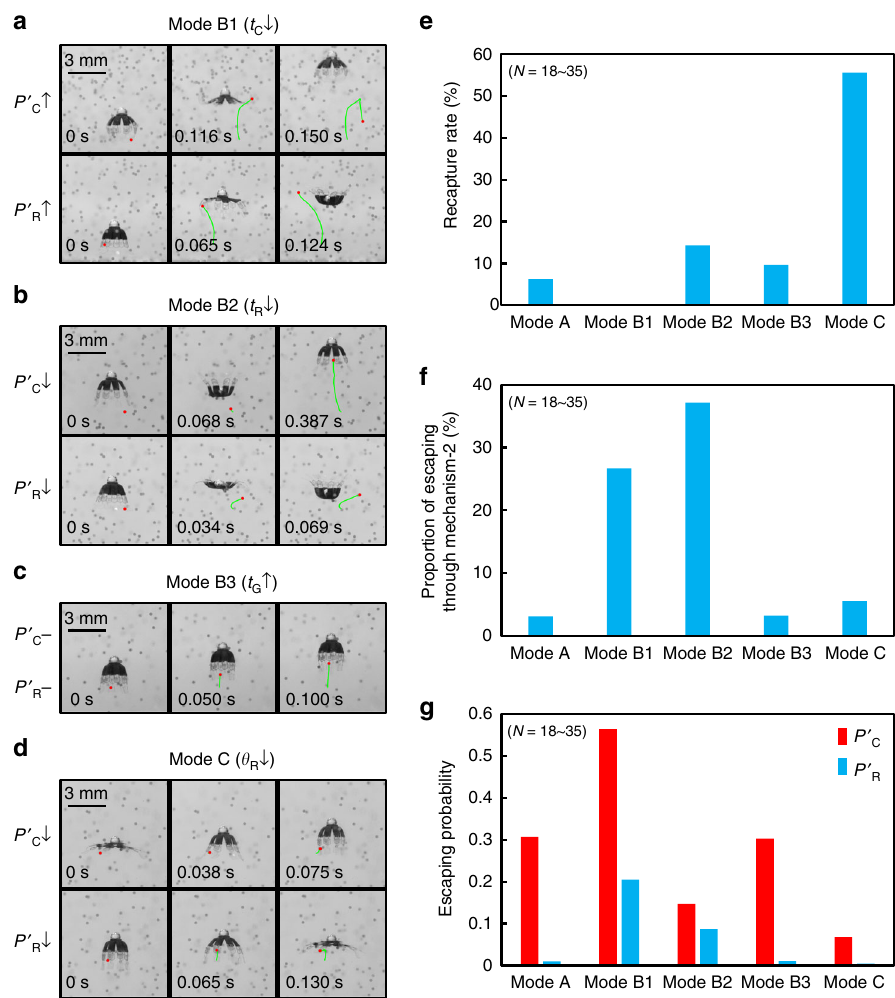
Fig. 5 The in fl uence of changing the kinematic parameters on object manipulation capability. a – d Typical trajectories of the neutrally buoyant beads achieved by different swimming modes. The changing in escaping probabilities are marked on the left. e Recapture rate of beads being transported. A higher value indicates a less chance to escape through Mechanism-1. f Proportion of the beads escaping through Mechanism-2. A higher value indicates a higher chance to escape through Mechanism-2. g The escaping probabilities estimated from experiments. In e – g , N represents the number of the counted